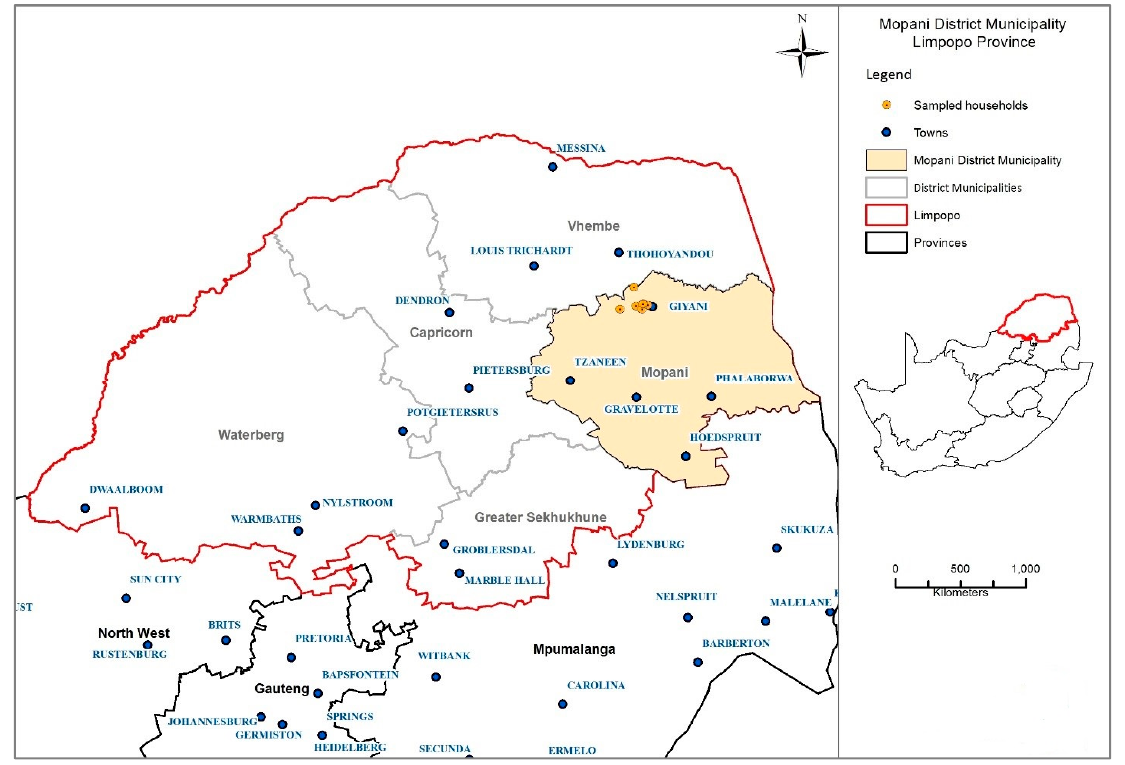
Figure 1. Map showing the location of Mopani District in Limpopo Province, South Africa (map produced in-house using ArcGIS ® software (version 10.3) created by ESRI (Environmental Systems Resource Institute, Redlands, CA, USA)).